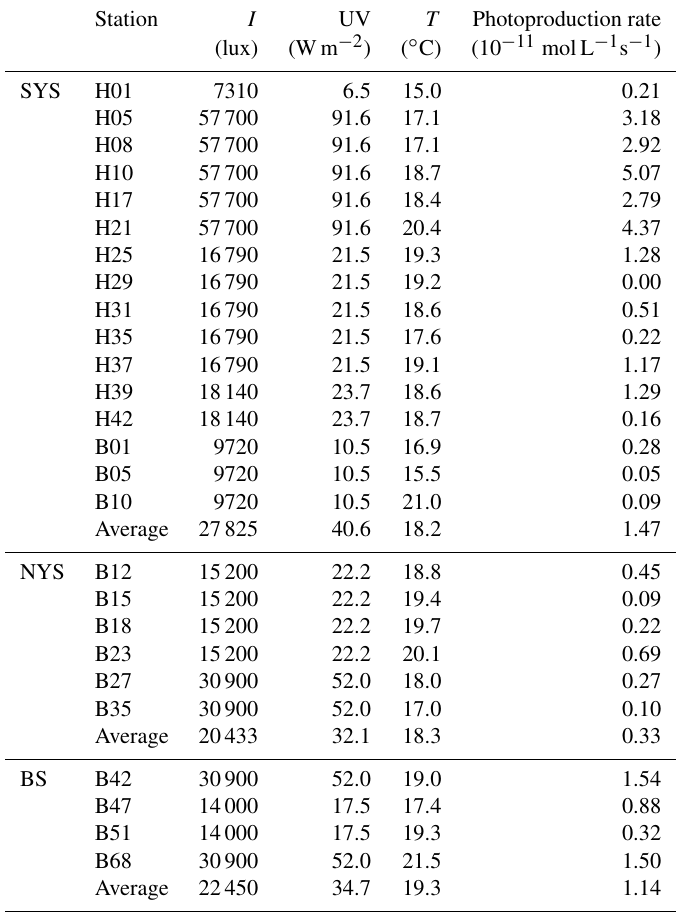
Table 2. Description of sampling stations and their seawater temperature ( T ), illuminance ( I ), mean surface downward UV radiation flux (UV), and photoproduction rates in the BS and the YS.